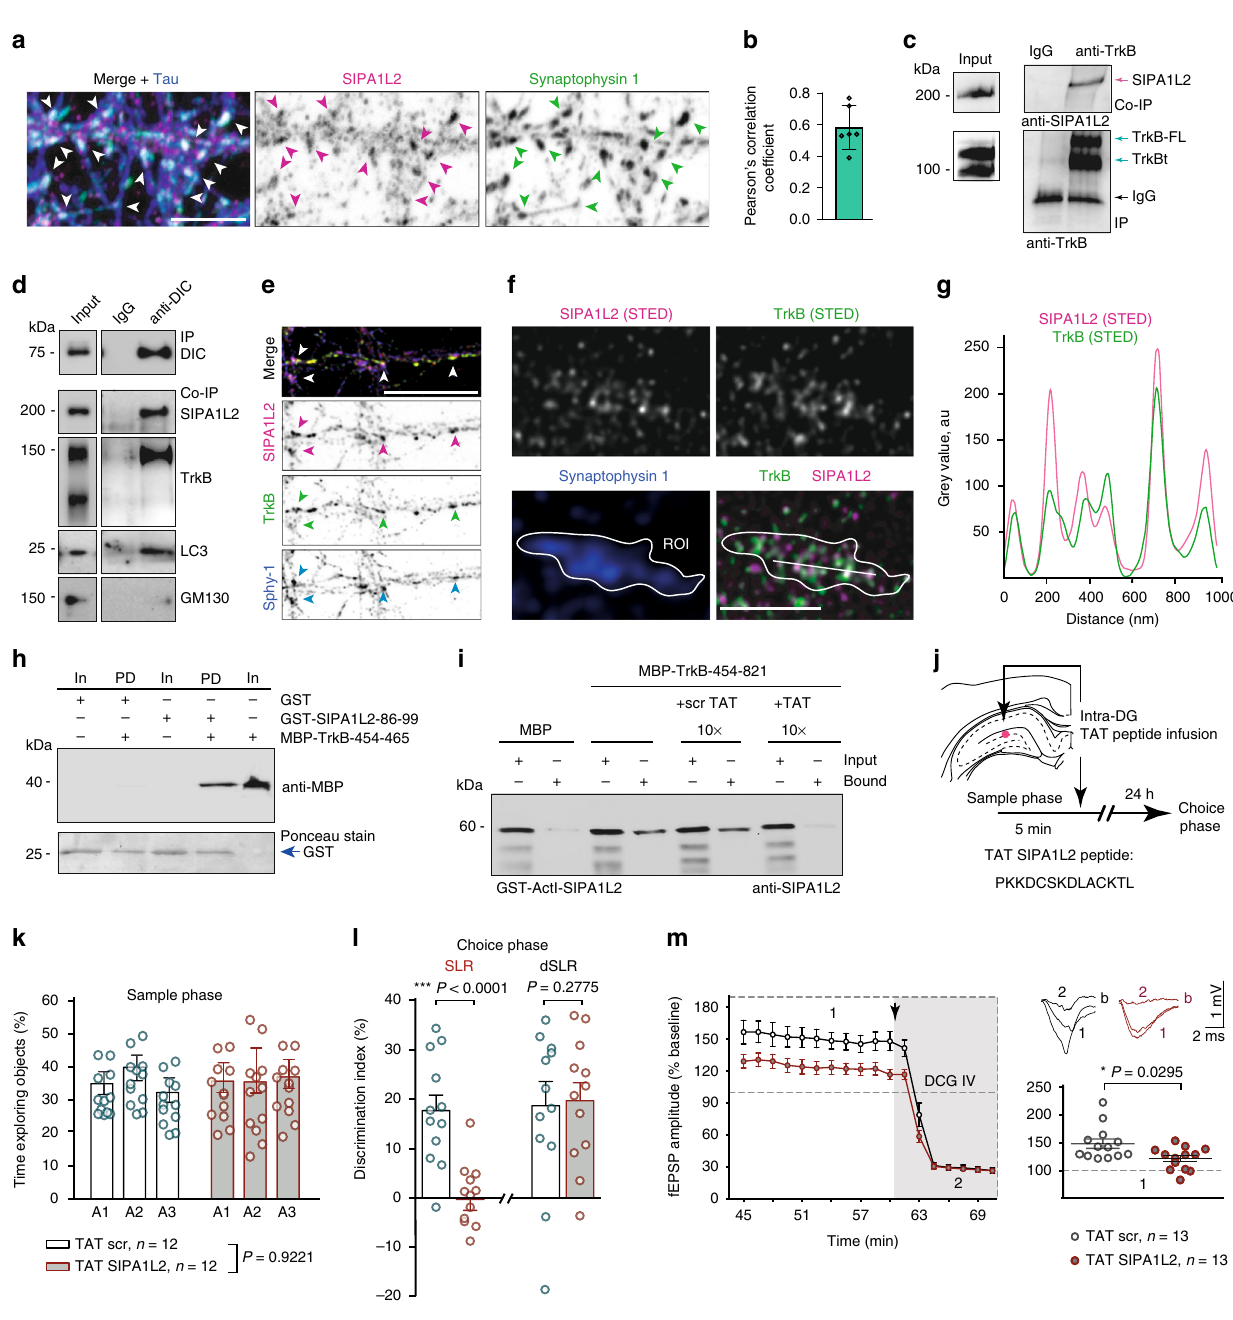
Fig. 2 SIPA1L2/TrkB interaction at presynapses is crucial for the function of the DG. a Confocal images of rat hippocampal neurons immunostained against SIPA1L2, Synaptophysin 1 and Tau. Scale bar is 5 μ m. b Pearson ’ s correlation coef fi cient calculated for SIPA1L2 and Synaptophysin 1 from a . Circles represent averaged values per region of interest (ROI) analyzed from three independent images. c Endogenous TrkB coimmunoprecipitates SIPA1L2 from rat hippocampal lysates. The two bands in TrkB correspond to the full length (TrkB-FL) and the truncated form (TrkBt). Goat anti-TrkB antibody (R&D) is used for precipitation and detection. d DIC coimmunoprecipitates SIPA1L2 and TrkB but not GM130 from mouse whole brain crude light membrane fraction. Note that the band revealing TrkB corresponds to the full-length form. e Confocal images from rat hippocampal neurons immunostained against SIPA1L2, TrkB and Synaptophysin 1 (Sphy1). Scale bar is 10 μ m. f STED images from hippocampal neurons immunostained against SIPA1L2, TrkB and Synaptophysin 1 (confocal). Line pro fi les ( g ) indicate relative intensities for STED channels along 1 µ m. Scale bar is 1 µ m. h Pull-down assay between the juxtamembrane region of TrkB and the 14aa of the binding interface in ActI-SIPA1L2. i Pull-down assay between TrkB and ActI-SIPA1L2 in the presence of 10× TAT binding peptide (TAT) or 10× scrambled peptide (TAT-scr). j Cartoon representing the timeline used for the pattern separation test performed in wt animals infused with TAT peptides and the location of the infusion (red dot). k Exploring time from mice injected with TAT-SIPA1L2 or TAT-scr during the sample phase (two-way ANOVA). l Discrimination indexes obtained during the choice phase in SLR and dSLR groups injected with either TAT-SIPA1L2 or TAT-scr. The number of subjects is depicted in k (unpaired Student ’ s t test). m fEPSP amplitudes recorded during the last 45 – 70 min after MF-LTP upon bath perfusion of TAT-SIPA1L2 or TAT-scr peptides. Right, averaged values of fEPSP amplitudes during last 10 min of LTP recording before DCG IV application (Mann-Whitney U test). Bars and error bars represent data as mean ± SEM in all graphs. Circles represent mean values of individual subjects ( k – l ) or slices ( m ). "*" indicates P ≤ 0.05; "***" indicates P ≤